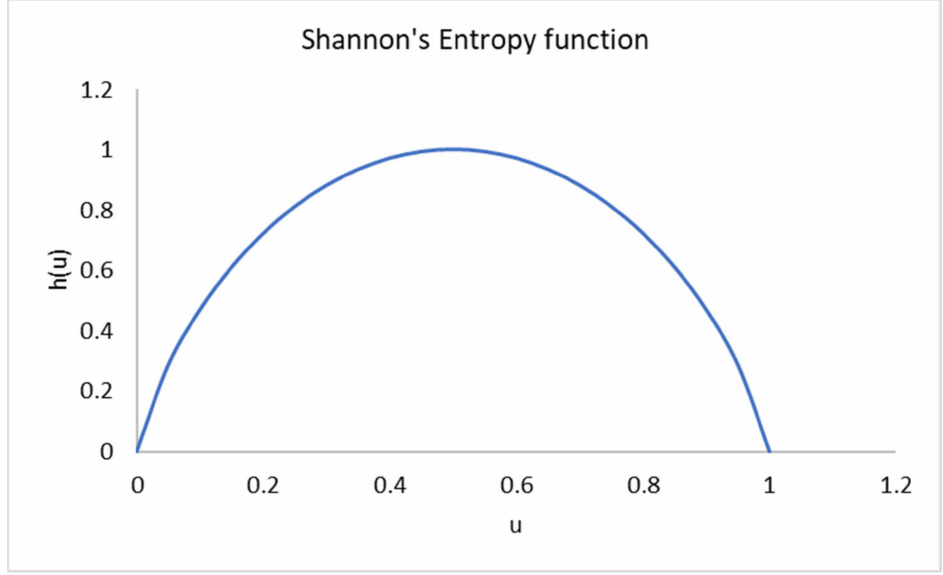
Figure 3. Shannon’s Entropy